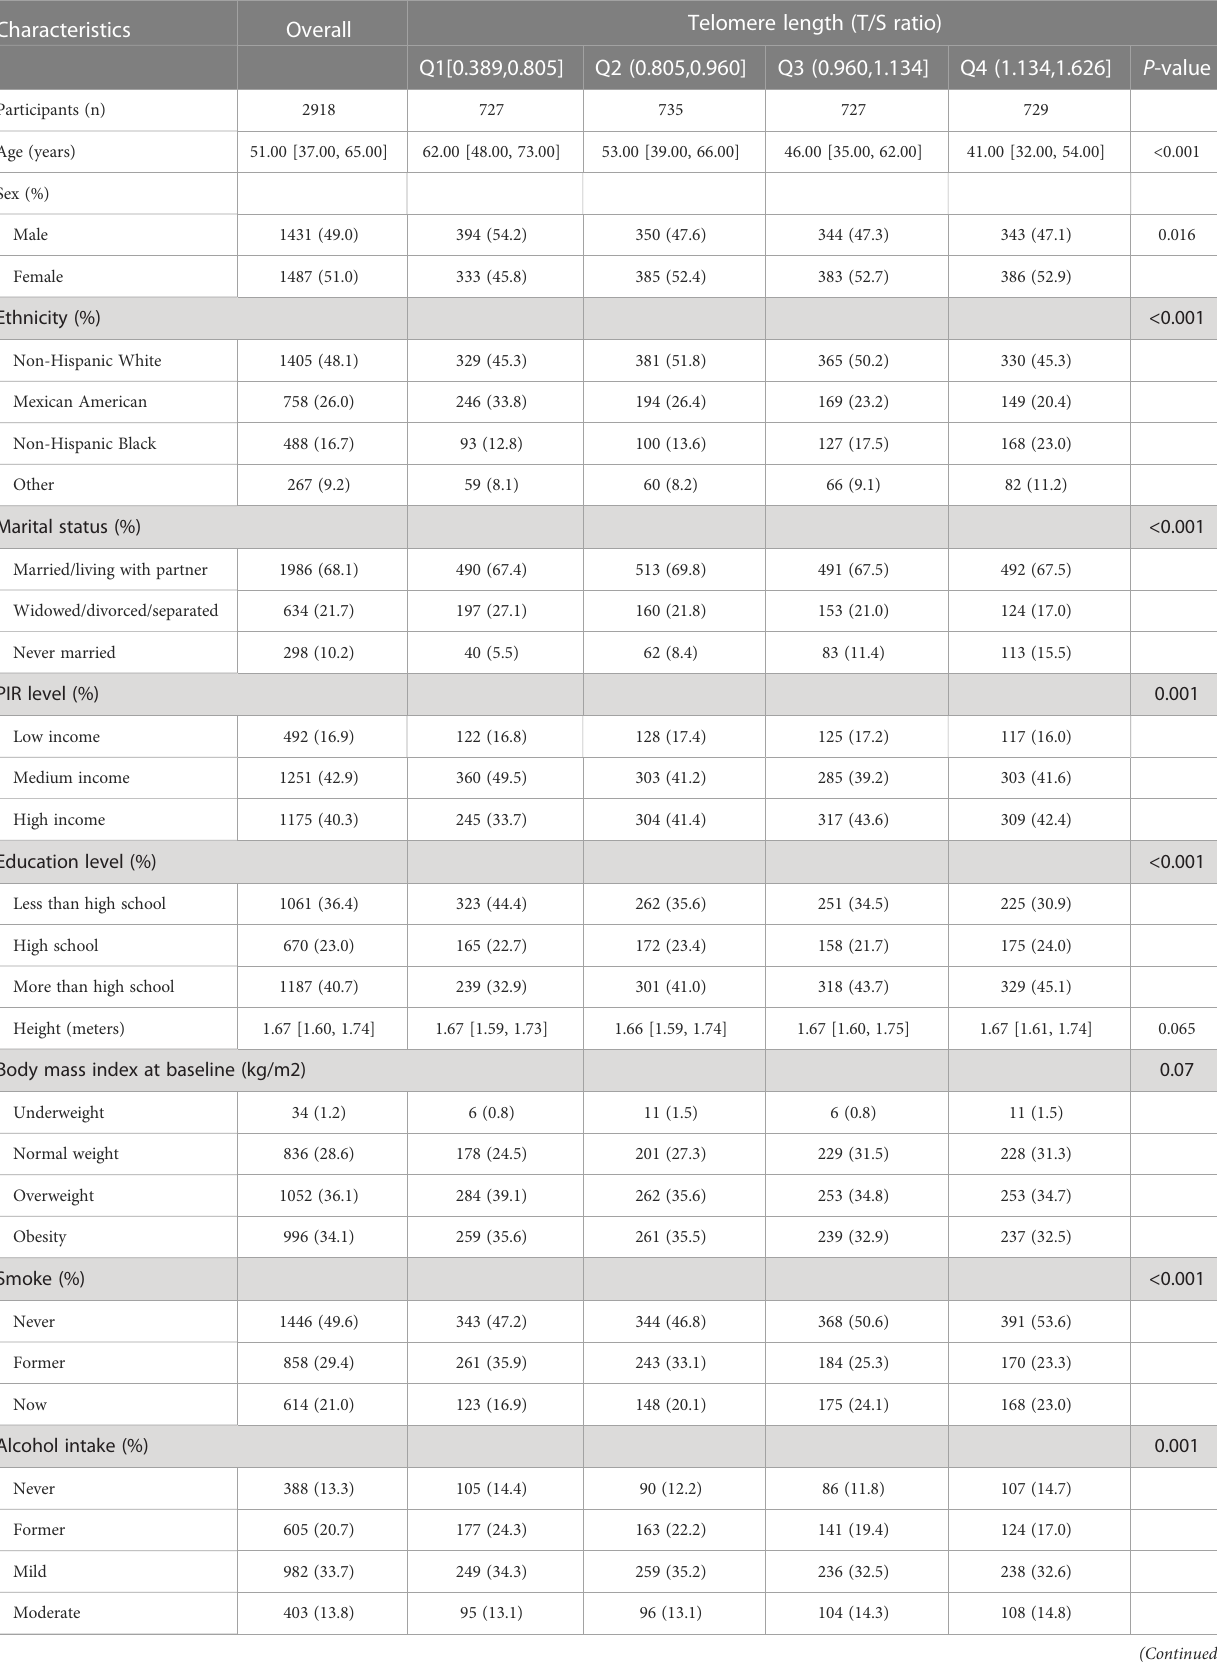
TABLE 1 Baseline characteristics of study participants in the NHANES 1999-2000 cycle.